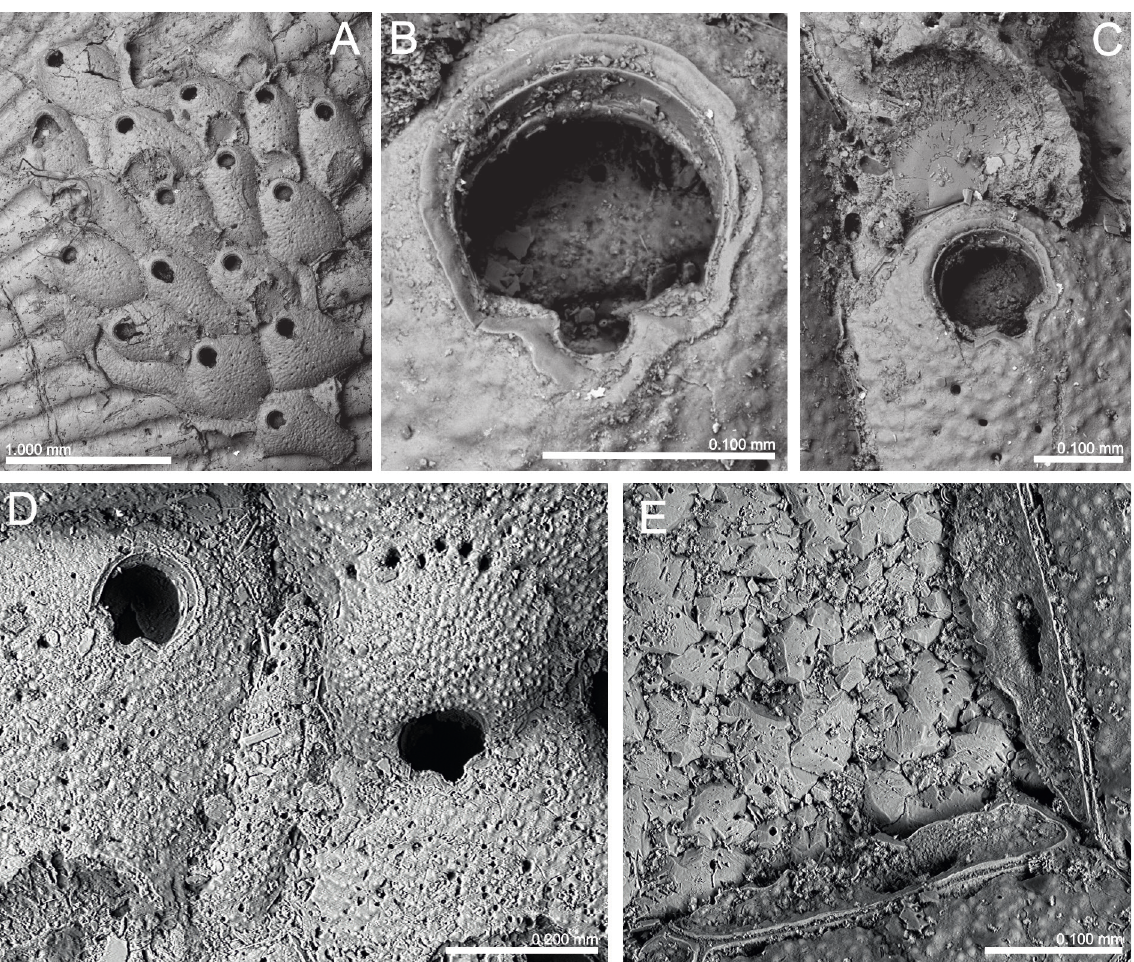
Fig. 5. Schizoporella ovum Jullien, 1882. A . Entire colony (NHMUK 1899.7.1.2348, lectotype). B . Same , primary orifice. C . Same, a broken ovicell showing the marginal pores. D . Ovicellate and non- ovicellate zooids (MNHN 2347, paralectotype). E . Dietella (MNHN 1025,